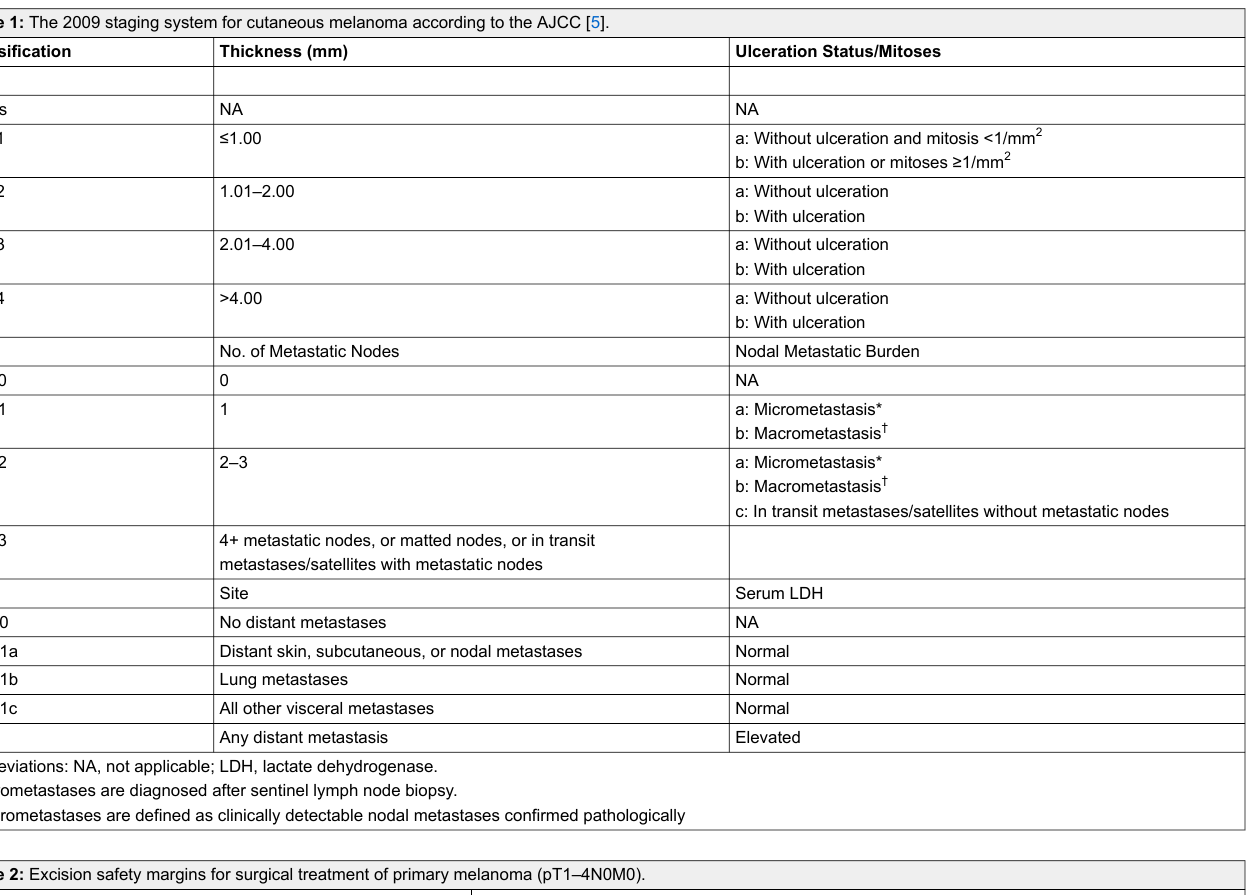
Table 2: Excision safety margins for surgical treatment of primary melanoma (pT1–4N0M0). Tumour thickness (Breslow) Excision safety margin, cm Melanoma in situ (tumour thickness is not indicated) (plisN0M0)